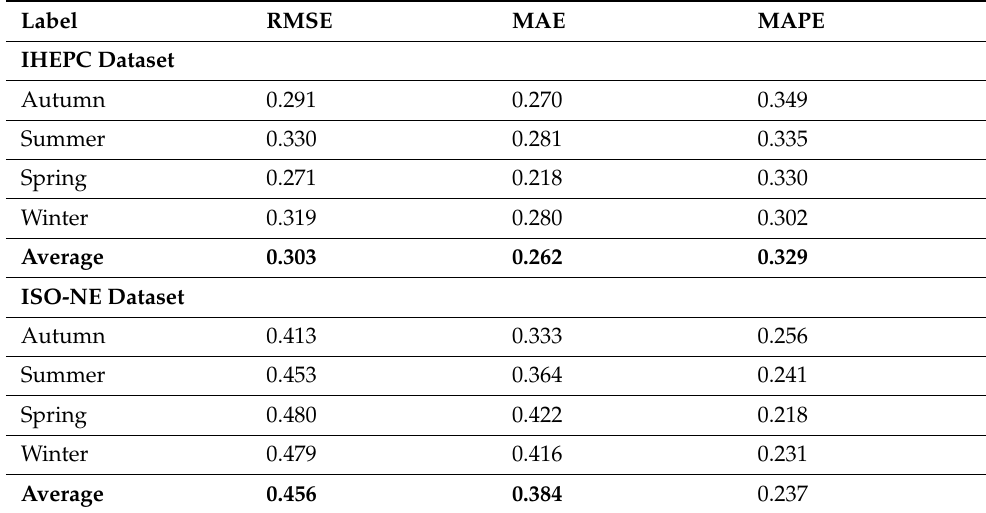
Table 1. Result analysis of AJODL-DSSEM technique with various measures under two